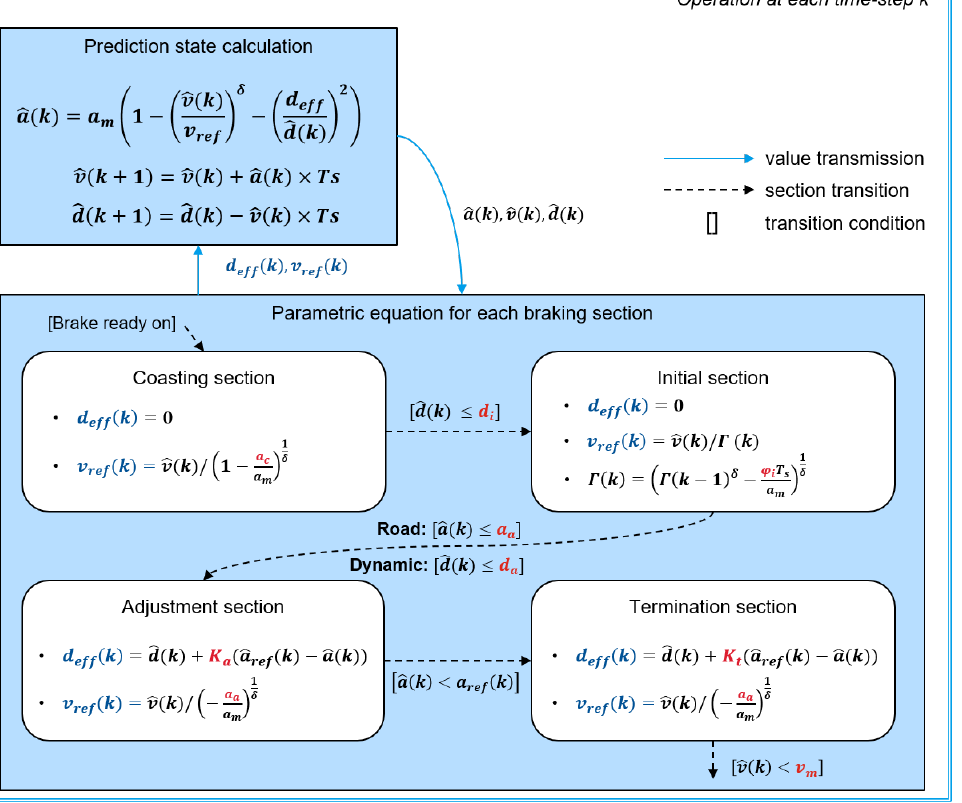
Figure 9. Detailed process for calculation of parametric model equations to predict deceleration